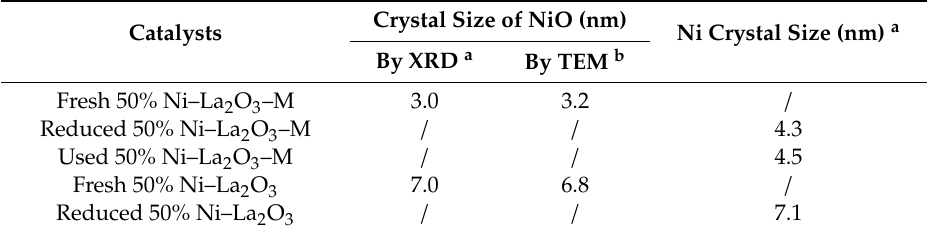
Table 2. Crystallite particle size of Ni and